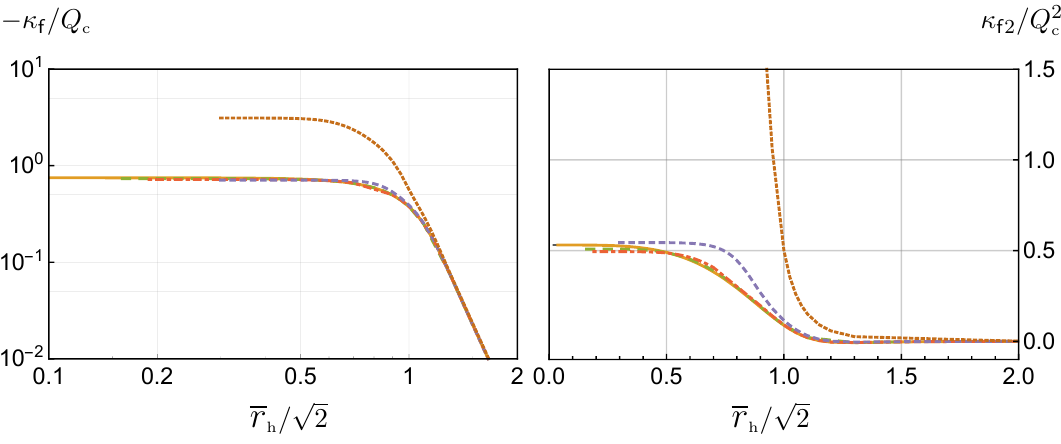
Figure 9. UV coe(cid:14)cients (cid:20) (cid:30) and (cid:20) b for di(cid:11)erent values of